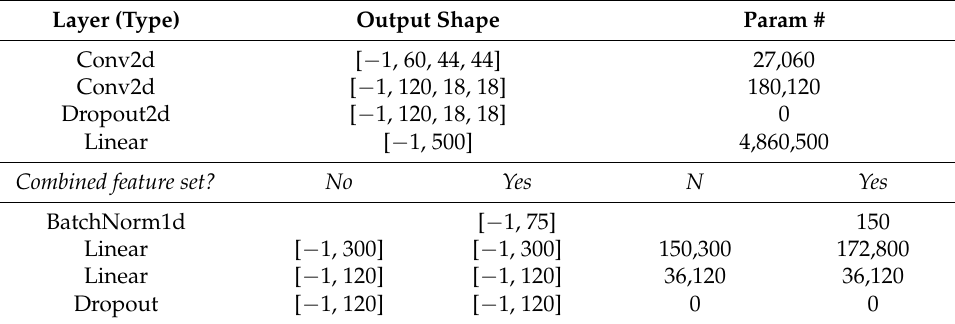
Table 1. Layer types, output shapes, and the number of parameters for the CNN that was used to classify the data. For the combined feature sets, the explicit features were added intermediately at the indicated